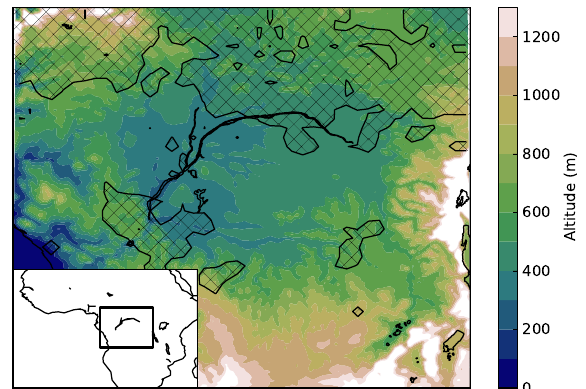
Figure 2. The domain used for the WRF-Chem simulations in this study. The colours indicate the altitude and the hatched areas indi- cate regions where MODIS detects more than one fire per 5000km 2 over the simulation time period. The inset shows the domain loca- tion over